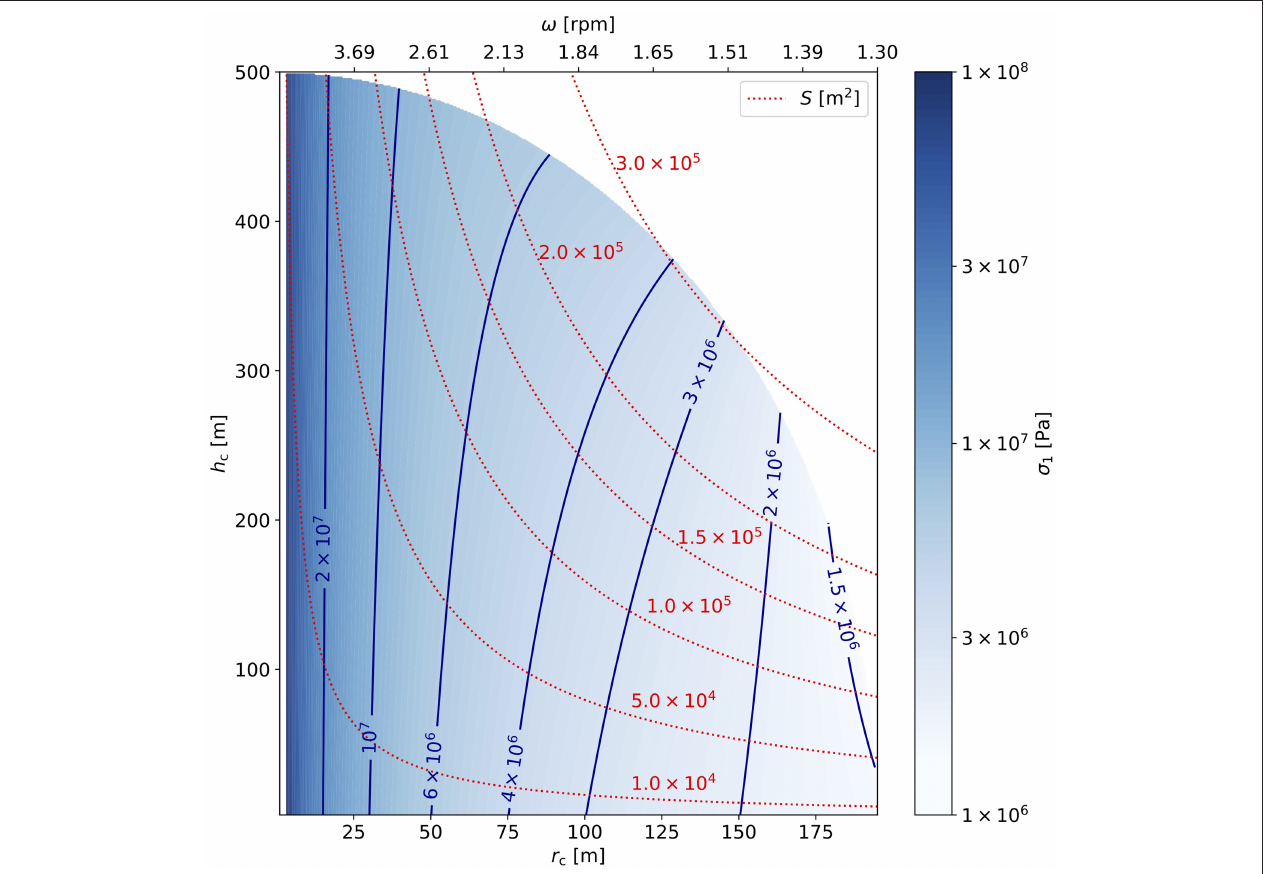
FIGURE 6 | Model 1 results for artificial gravity of 0.38g E in a space station of radius r c and height h c , the color code and the blue contour lines give the tensile stress σ 1 resulting from the required rotation rate obtained via (9). The red dotted lines give the usable surface area S of the space station, the upper x -axis denotes the required rotation rate.